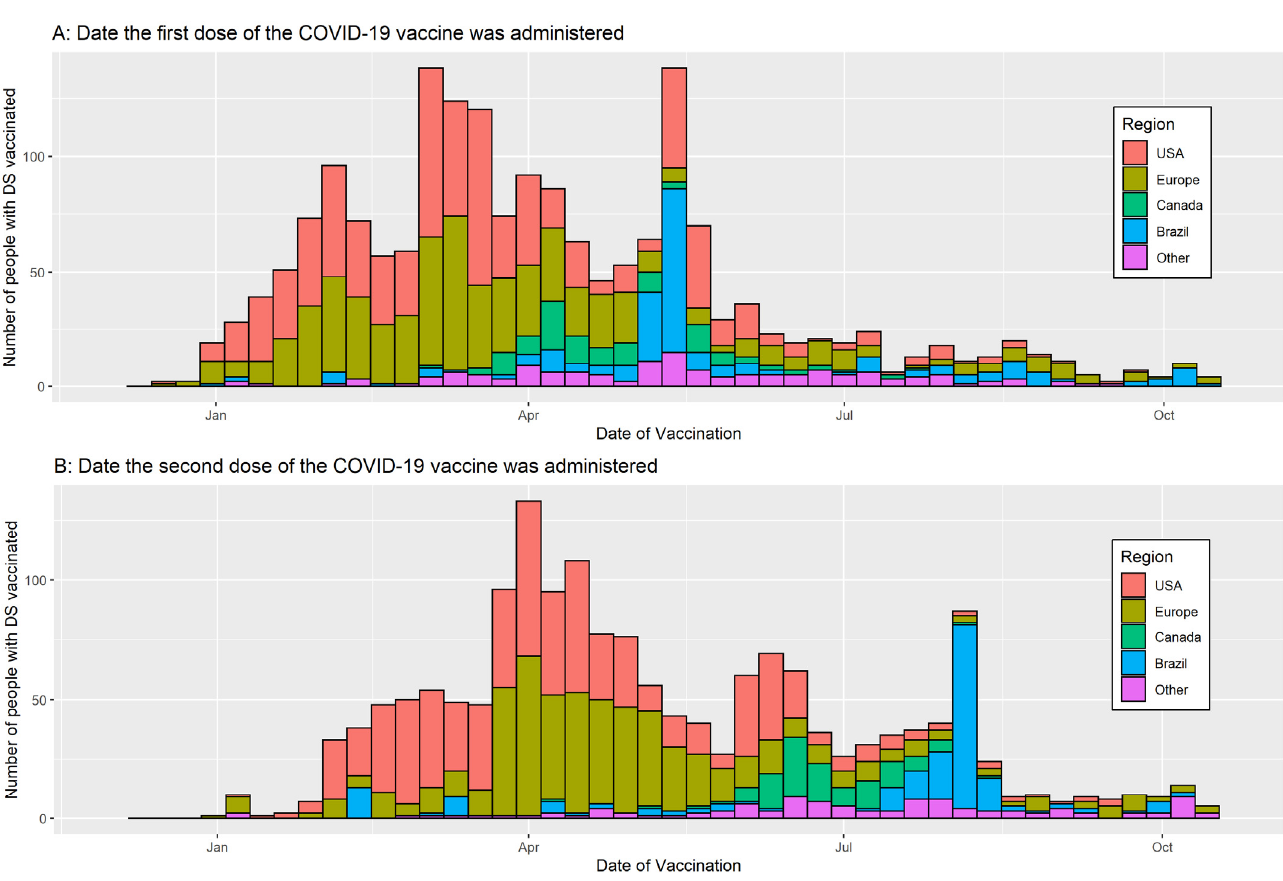
Figure 1. Date of vaccination stratified by first and second dose of the vaccine and country/region of